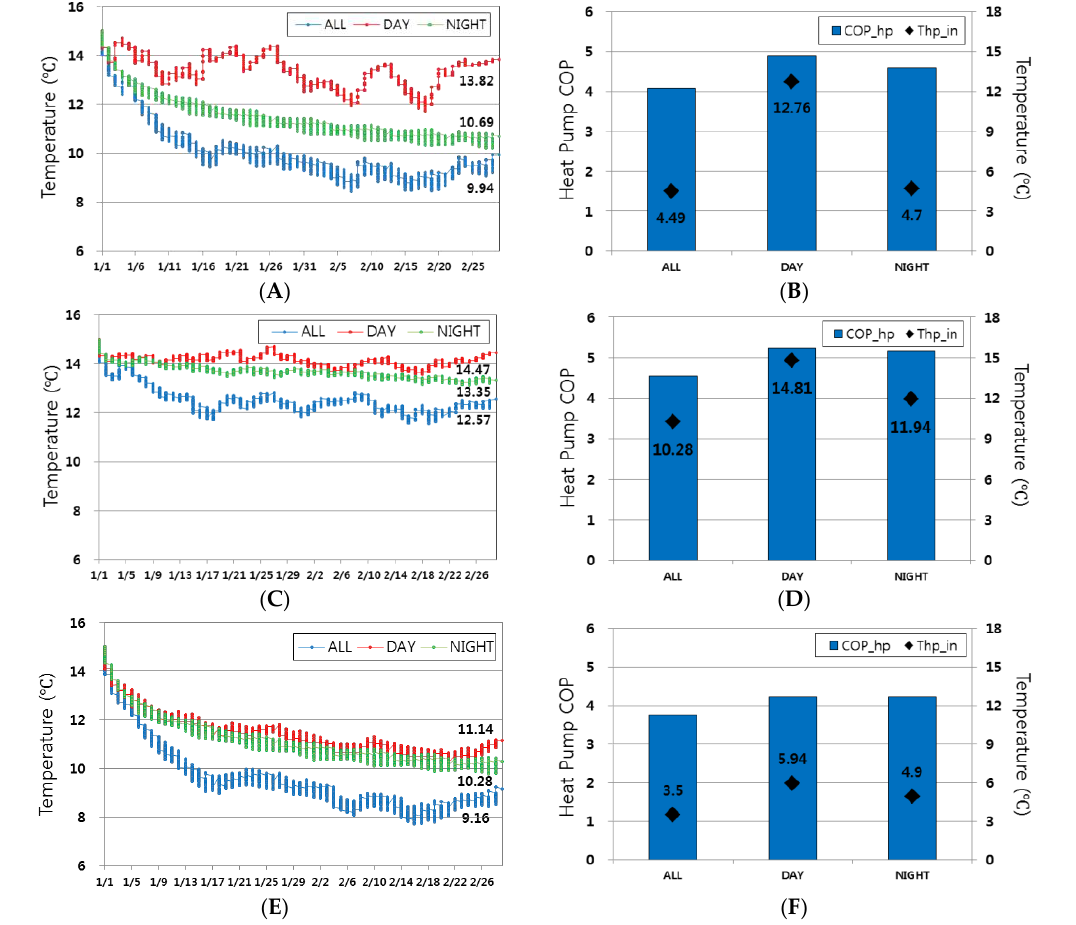
Figure 6. Simulation results of heat pump in case. ( A , C , E ) Ground temperature; ( B , D , F ) heat pump inlet temp. and COP; ( A , B ) SYSTEM 1; ( C , D ) SYSTEM 2; ( E , F ) SYSTEM 3.